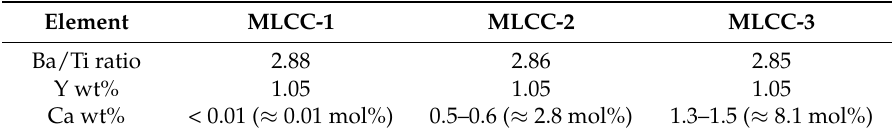
Table 1. Chemical composition of the initial powders used in this study. Values are obtained by Inductively Coupled Plasma emission spectra (ICP) analysis. For all powders, the trace elements (Sr, Si, Mn, Mg, Co) account for less than 0.8